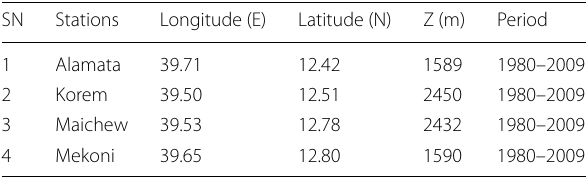
Table 1 Location of meteorological stations in the study